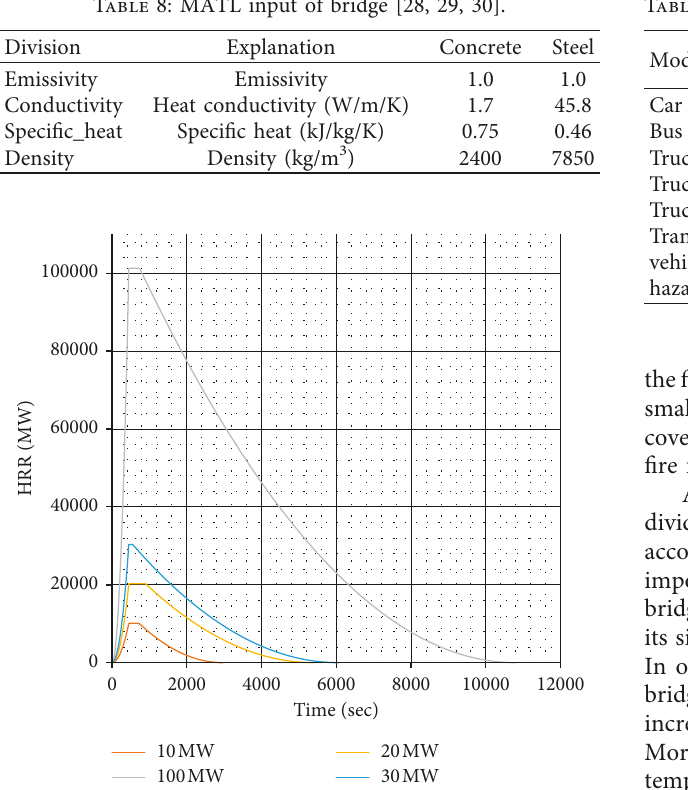
Figure 6: Standard fire curve for FDS model [31].